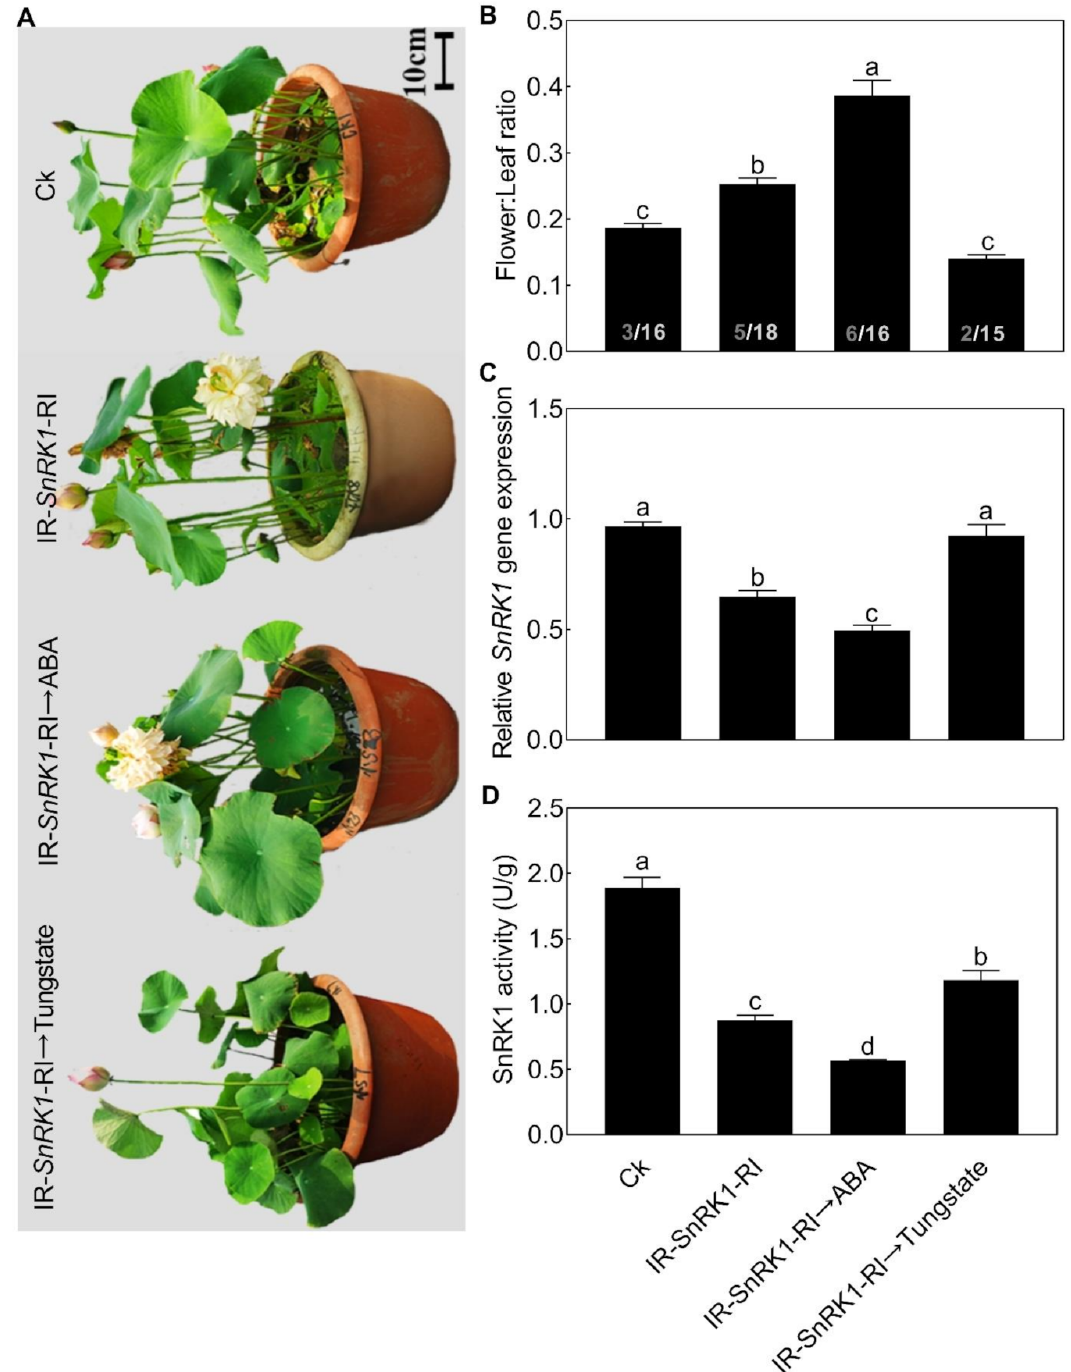
Figure 9. Effects of abscisic acid (ABA) and tungstate on NnSnRK1 -silenced (IR- NnSnRK1 -RI) and -overexpressed (pIR- NnSnRK1 ) lotus. Two-month-old lotus seedlings were used for infection with IL-60-BS-derived systems. IR- NnSnRK1 -RI, NnSnRK1 -silenced lotus; pIR- NnSnRK1 , NnSnRK1 -overexpressed lotus. After being infected for 14 days, seedlings were treated with ABA (80 µ M) or tungstate (4.5 mM) for another 9 days. Then, the representative picture was taken ( A ) and the flower:leaf ratio ( B ), gene expression level ( C ), and activity of NnSnRK1 ( D ) were analyzed. NnSnRK1 -silenced and -overexpressed lotus seedlings were generated with the IL-60-BS-derived systems. The numbers on the bottom of each column represent the corresponding number of flowers and leaves of the flower:leaf ratio. Values are the means ± SE of three independent experiments with at least three replicates for each. Bars marked with different letters are significantly different from each other at p < 0.05, according to Tukey’s multiple